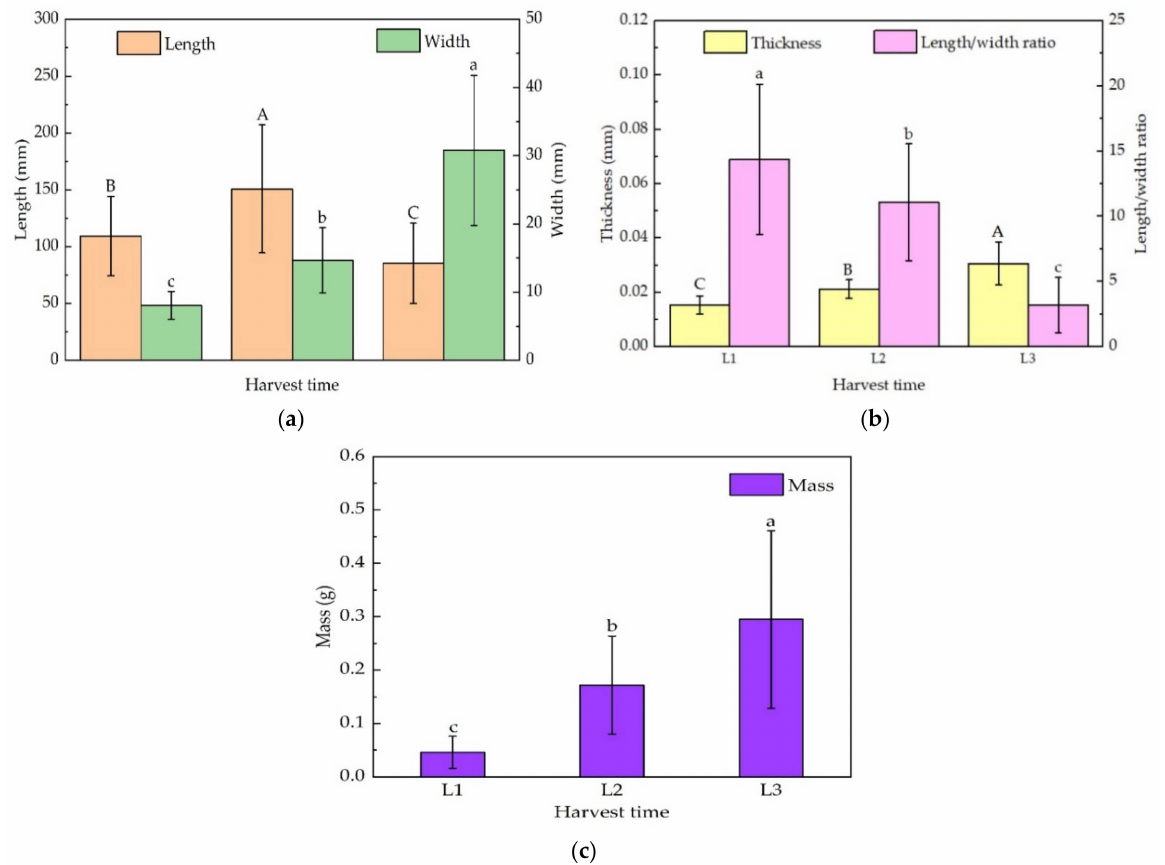
Figure 6. Biological properties of laver from different harvest times: ( a ) the effect of harvest time on length and width of laver; ( b ) the effect of harvest time on the thickness and length-to-width ratio of laver; ( c ) the effect of harvest time on the mass of laver. The different uppercase and lowercase letters indicate a significant difference between groups ( p < 0.05), while same uppercase and lowercase letters indicate no significant difference between groups ( p >